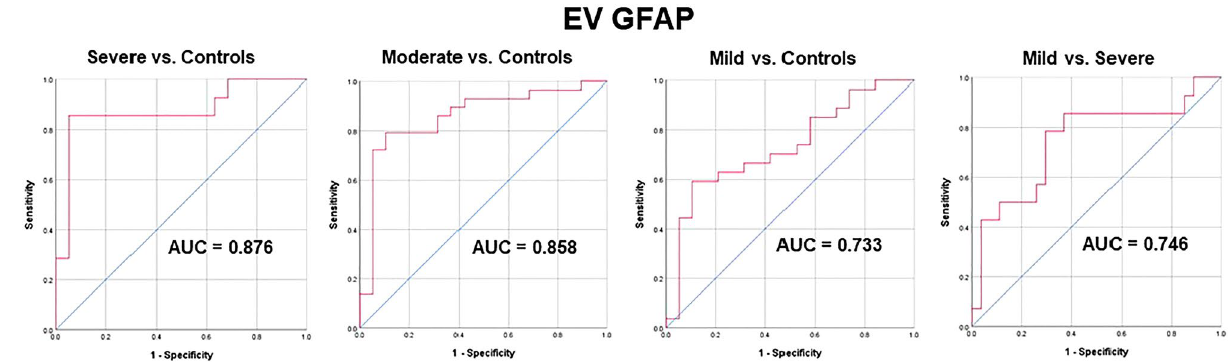
Figure 2. Receiver-operating characteristic curves comparing TBI severities and TBI to control. The diagonal blue line indicates the reference line (AUC = 0.5). GFAP glial fibrillary acidic protein, EV extracellular